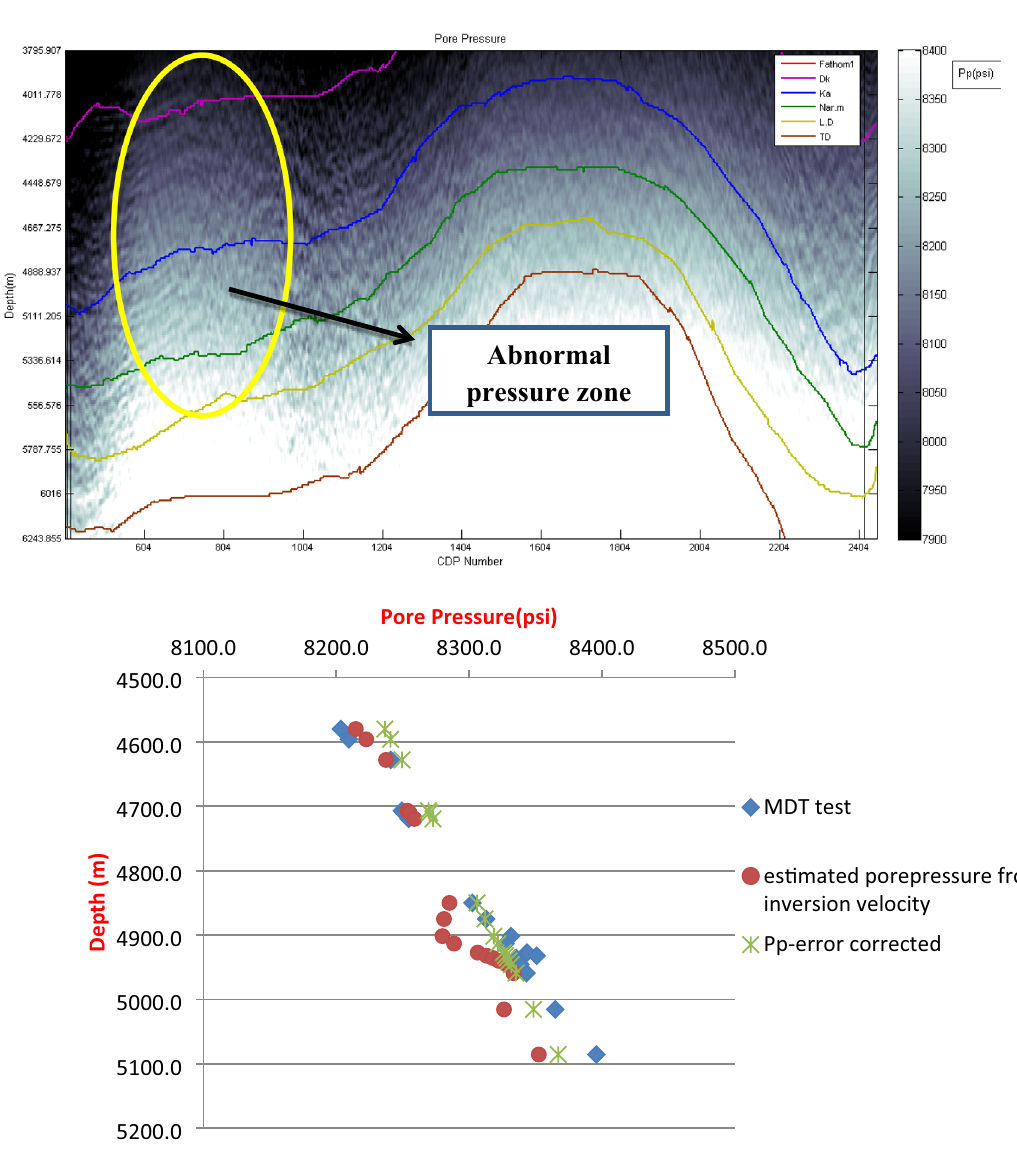
Fig. 9 Pore pressure model of Sefid-Zakhor derived by the subtraction of effective pressure from overburden pressure. a Graphical result of pore pressure in the whole area. b Estimated pore pressure in the well